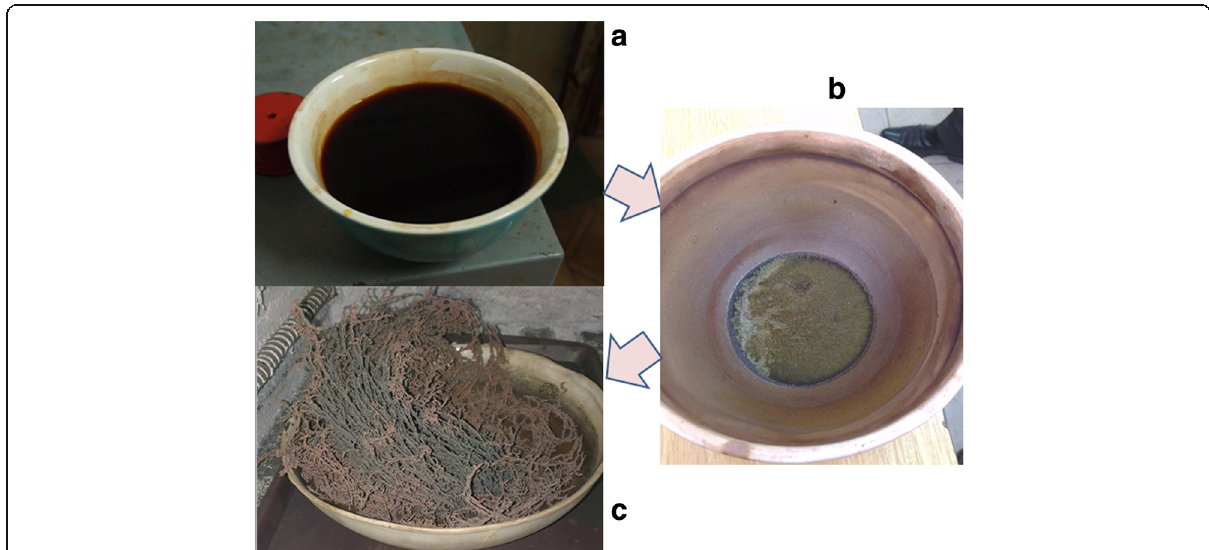
Fig. 1 The procedure for obtaining nanodispersed magnesium-substituted lithium ferrite by sol – gel auto combustion. a Precursor solution. b The dried gel the powder obtained after auto combustion